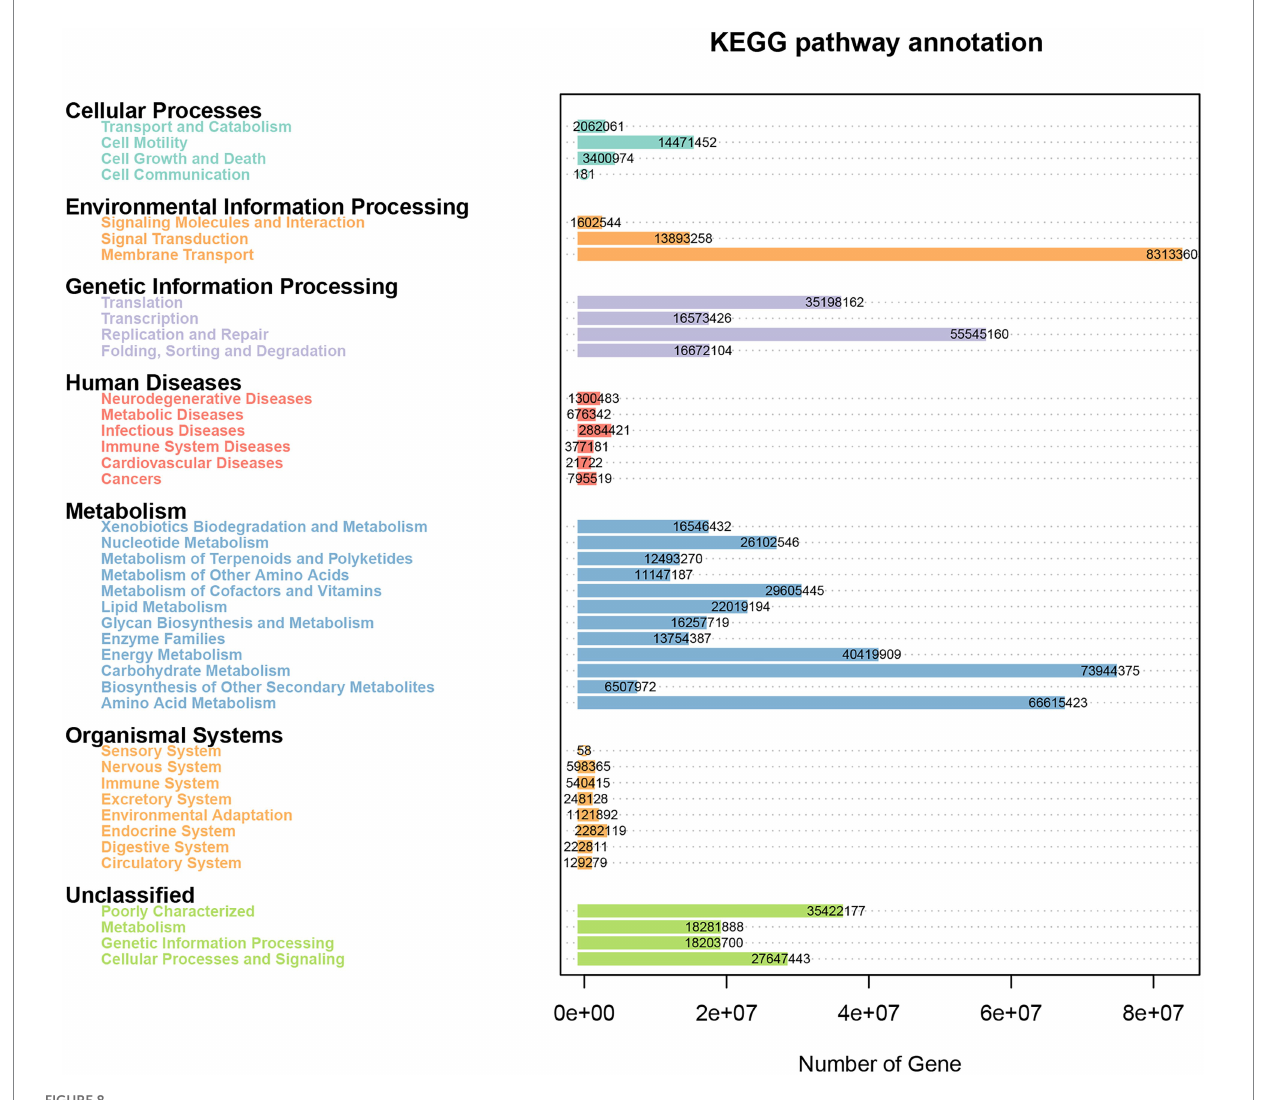
FIGURE 8 Heatmap of the KEGG pathways annotated by